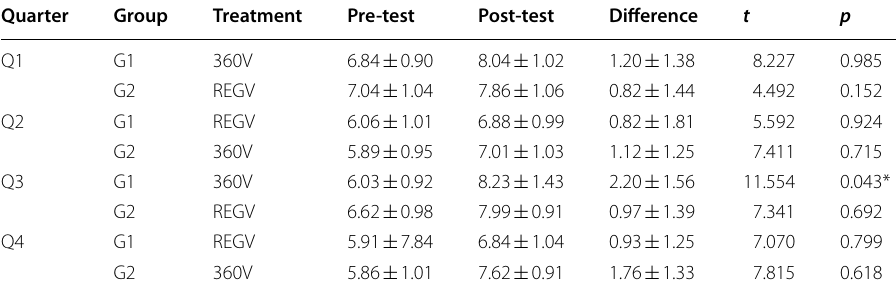
Table 2 Paired t-test results of before and after VFTs